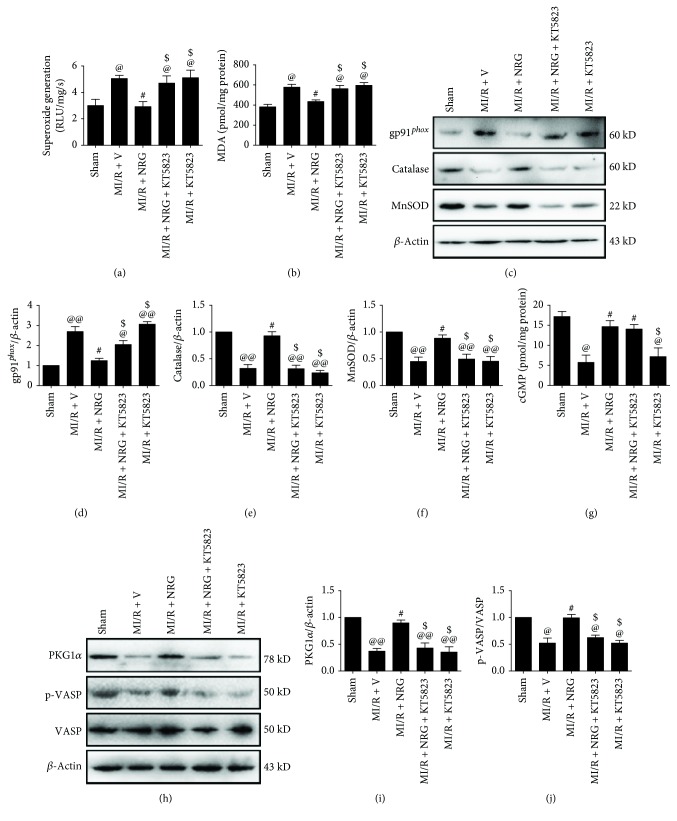
Evaluation of myocardial oxidative stress markers and cGMP-PKGIα signaling. All the measurements were carried out after 4 hours of reperfusion. (a) Myocardial superoxide generation, (b) myocardial malondialdehyde (MDA) contents, (c) representative blots, (d) gp91phox expression, (e) catalase expression, (f) MnSOD expression, (g) myocardial cGMP level, (h) representative blots, (i) PKGIα expression, and (j) VASP (Ser239) phosphorylation. Data are expressed as mean ± SEMn = 6 per group. @P < 0.05/@@P < 0.01vs. sham group, #P < 0.05vs. MI/R + V group, and $P < 0.05/$$P < 0.01vs. MI/R + NRG group. MI/R: myocardial ischemia-reperfusion; V: vehicle; NRG: naringenin.